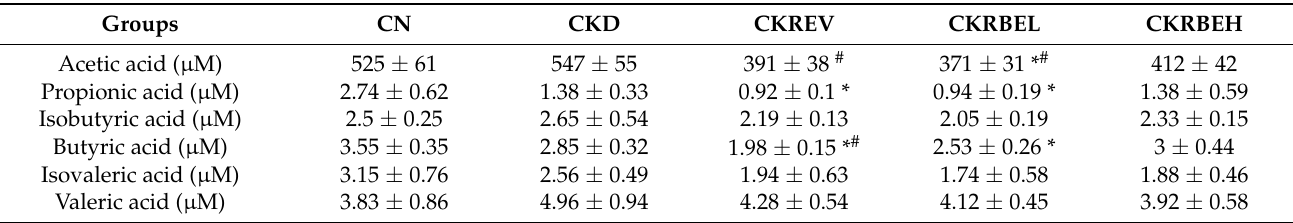
Table 4. Plasma short chain fatty acid